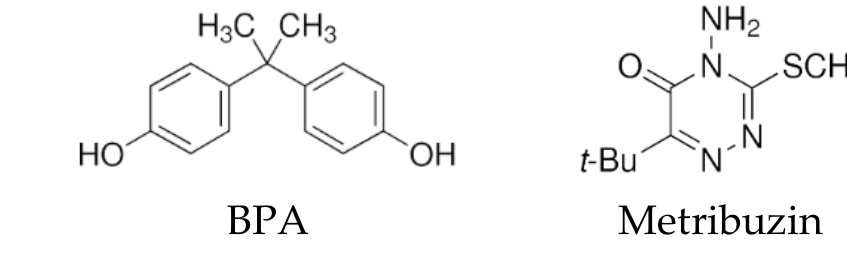
Figure 1. Chemical structures of the compounds.